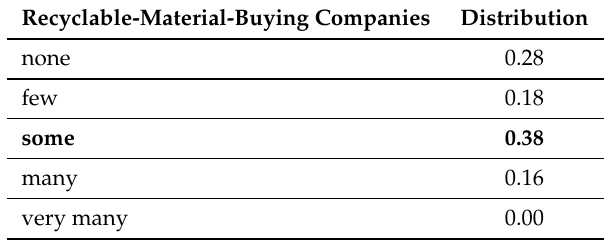
Table 13. Overall distribution of the categorical variable “recyclable-material-buying companies”.